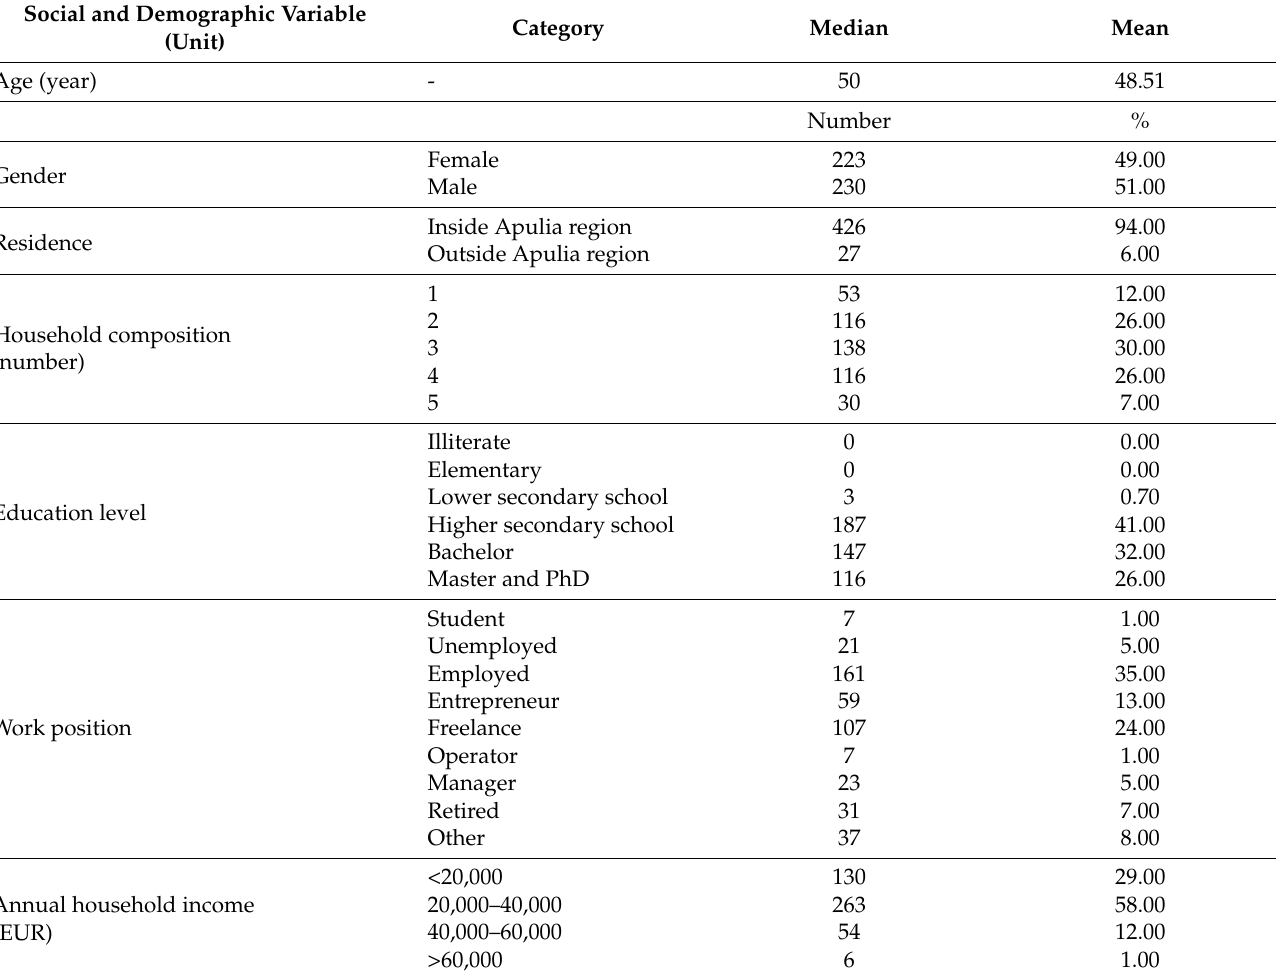
Table 9. Socioeconomic characteristics of the respondents.